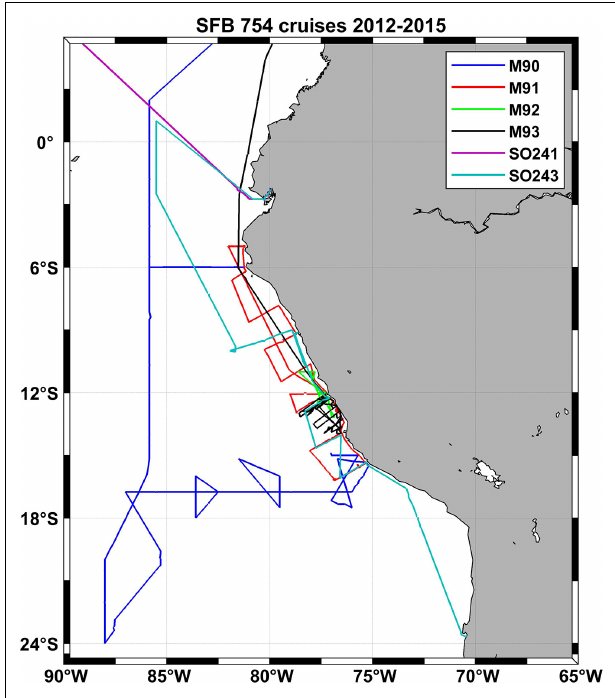
FIGURE 6 | Cruise tracks of six SFB 754 cruises in the Pacific in the second funding period of the project (2012–2015).